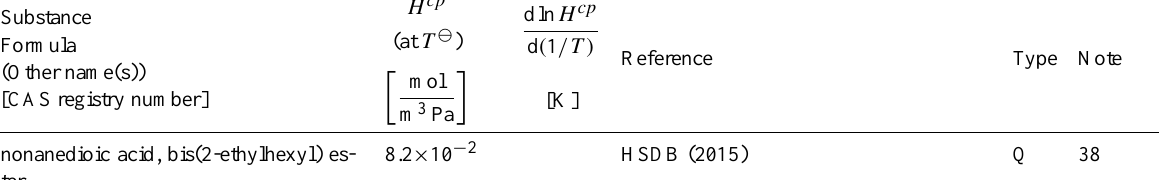
Table 6: Henry’s law constants for water as solvent